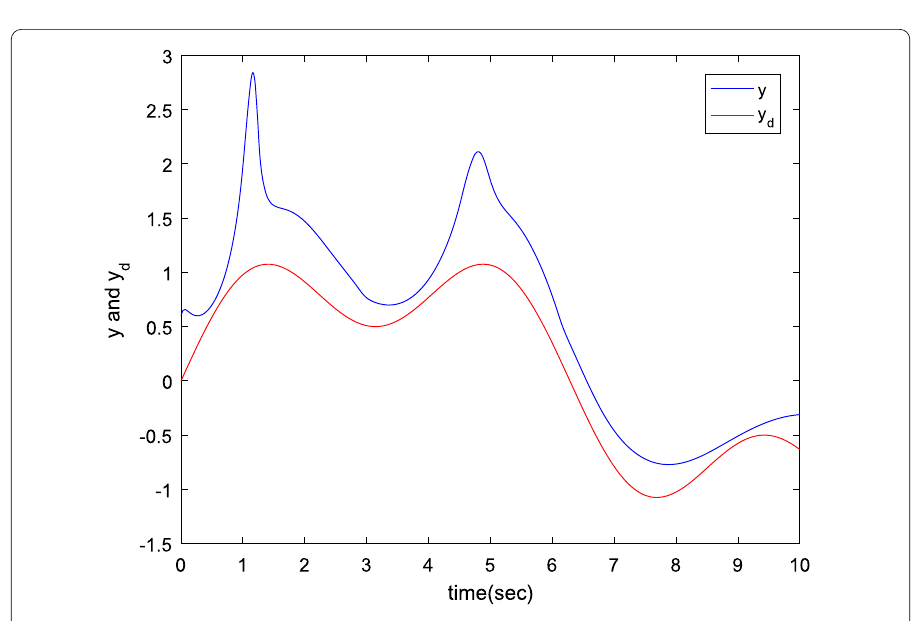
Figure 6 y and y d with ℘ =